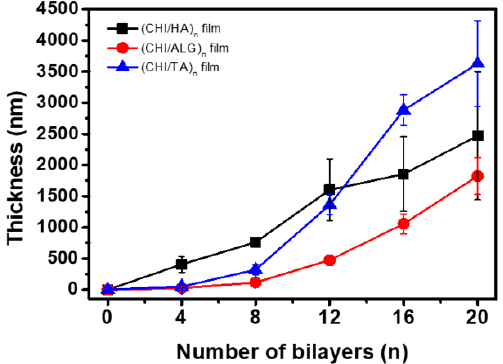
Figure 2. Growth curve of the multilayer film thickness on the Si wafer as the number of layers increased.